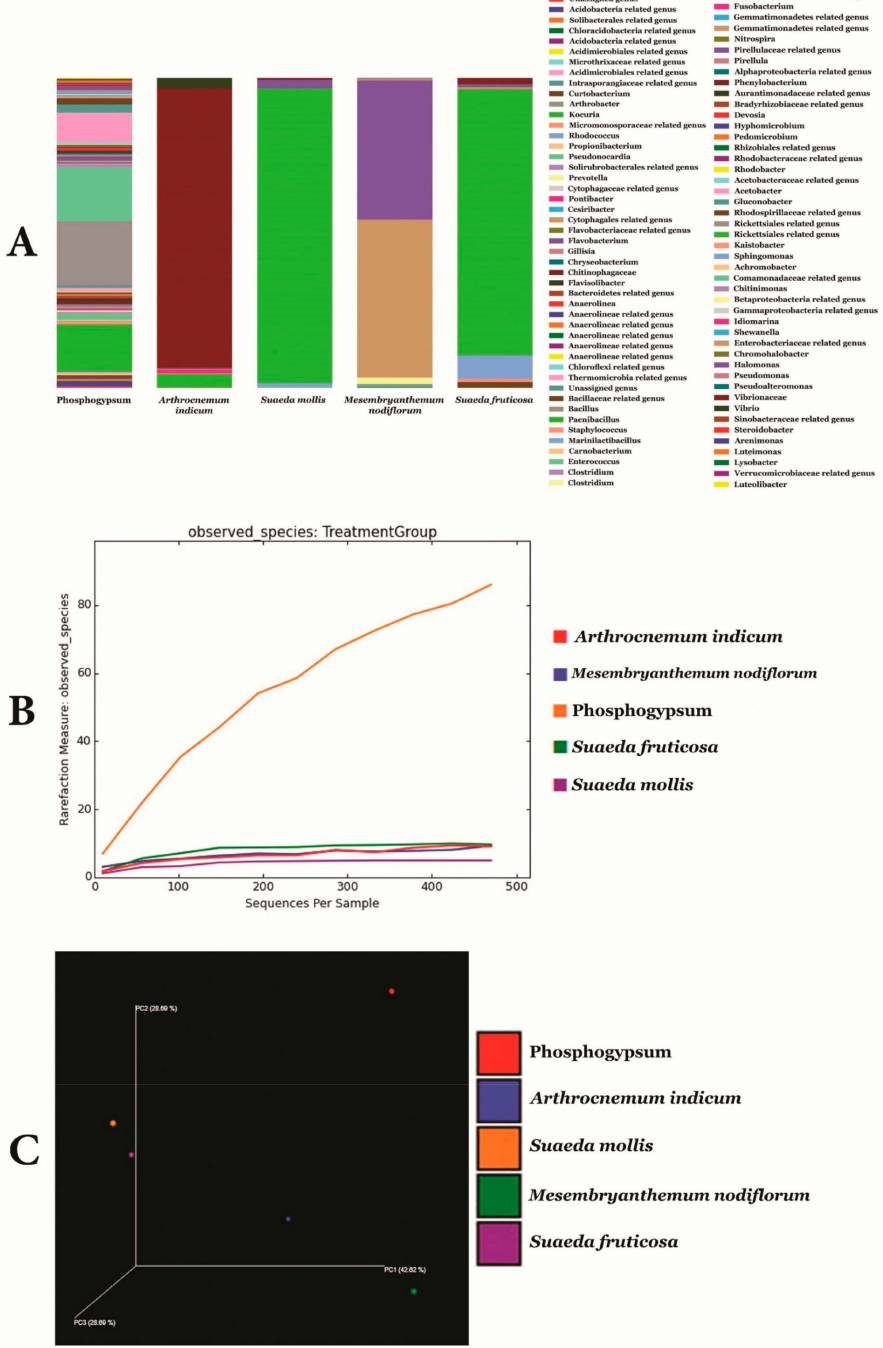
Figure 2. Genus level relative microbiome composition ( A ) Microbiome rarefaction curves ( B ) and principal coordinates analysis ( C ) of phosphogypsum and plant microbiomes generated using